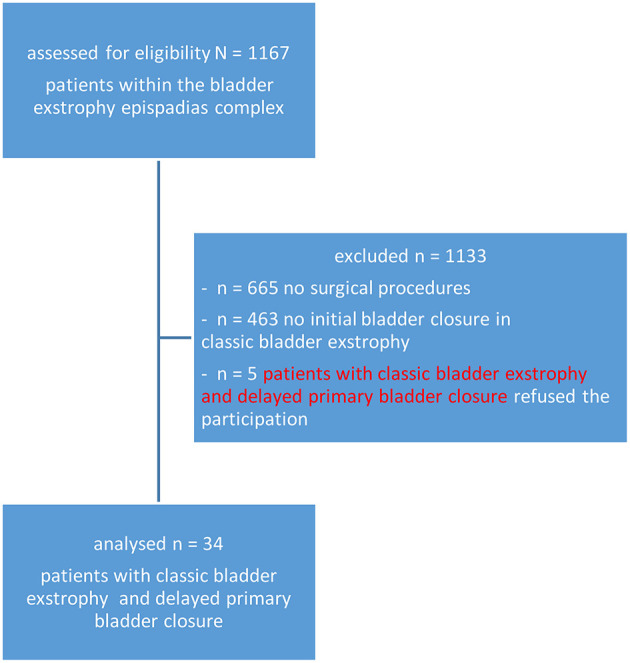
Flow-chart of patients.